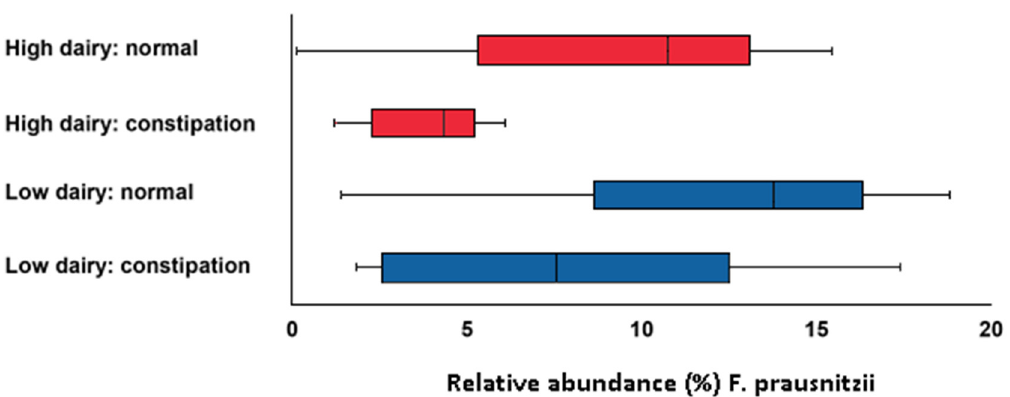
Figure 5. Relative abundance of Faecalibacterium prausnitzii for subjects with constipation (Bristol stool chart score of 1 or 2) and normal consistency (Bristol stool chart score of 3, 4 and 5) in the LDD and HDD ( p = 0.01).